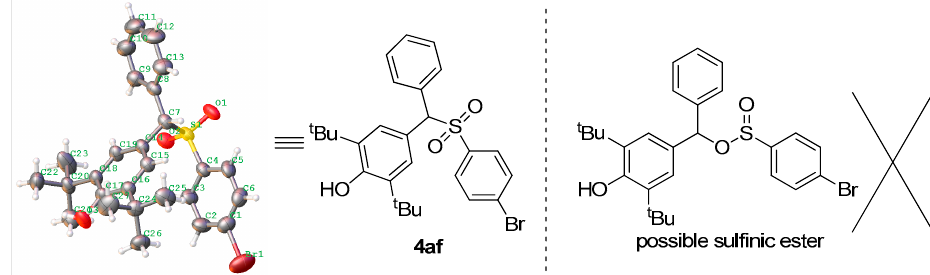
Figure 4. Crystal structure of diarylmethyl sulfone 4af and possible sulfinic ester.